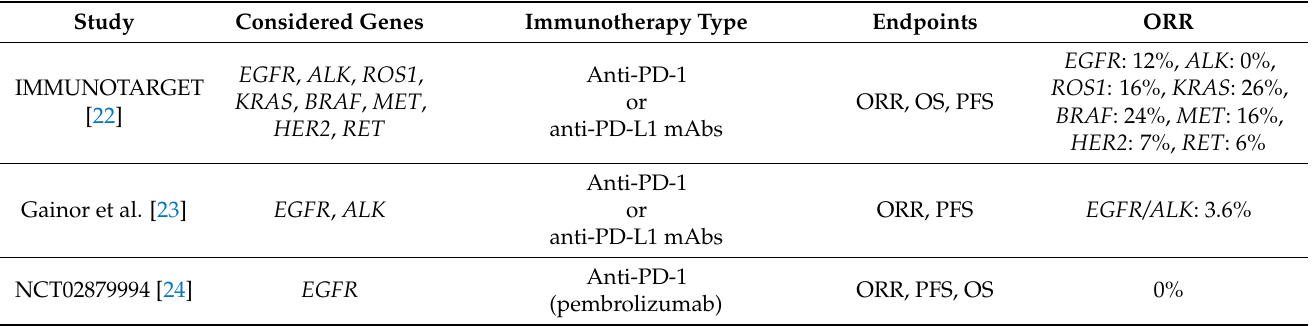
Table 2. Chosen studies concerning immunotherapy in NSCLC patients with driver